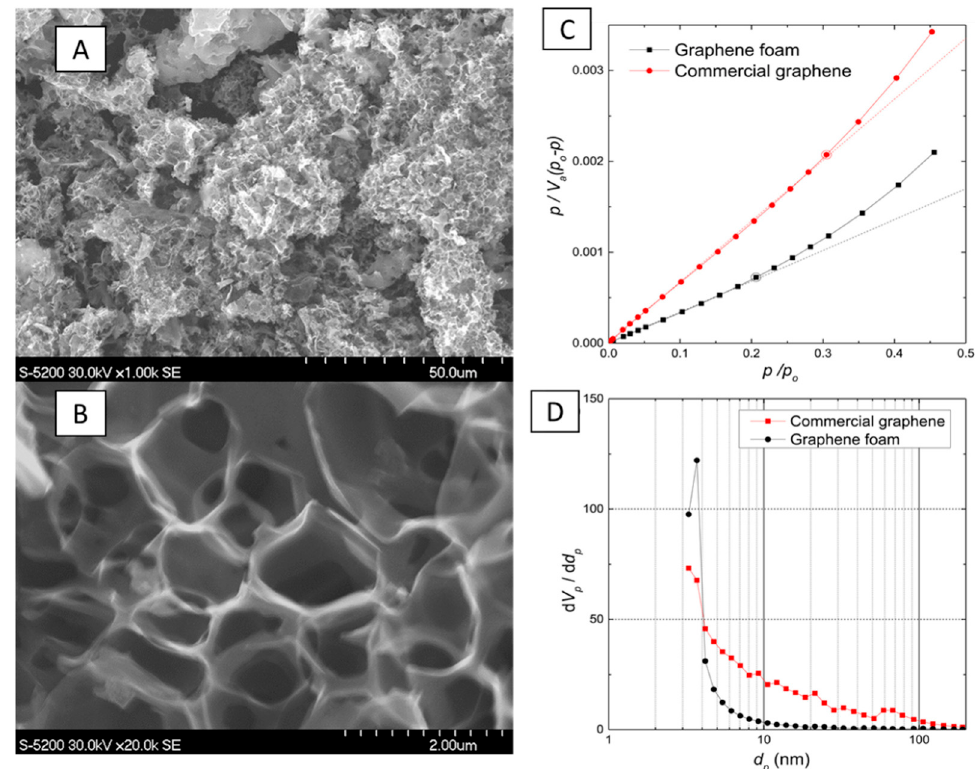
Figure 10. On the left-graphene foam, images obtained via SEM ( A , B ). On the right-comparison of commercial graphene and a graphene foam in terms of ( C ) BET surface area; ( D ) pore size distribution. Reproduced with permission from Lyth et al., International Journal of Hydrogen Energy; published by Elsevier, 2014.